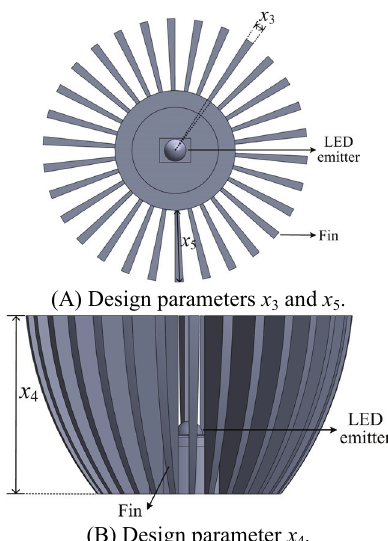
Fig. 4. Illustration of geometric design parameters of a heat